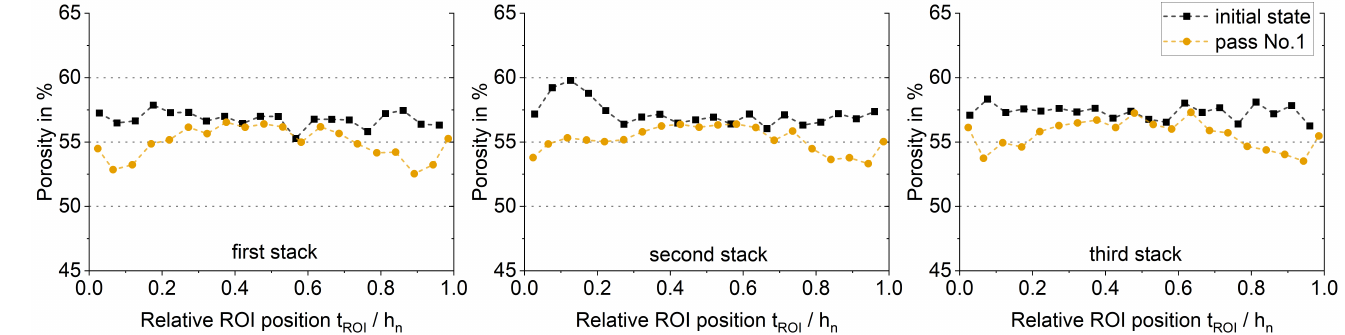
Figure 14. Cross Sections of reconstructed volumes from CT Scans for sample 20-0.50-20 (RD: rolling direction, TD: thickness direction i.e., roll gap direction, WD: width direction i.e., roll width direction, white: material, black: pores): ( a ) RD-WD at t ROI / h n = 0.1 after pass No. 16. ( b ) RD- WD t ROI / h n = 0.5 after pass No. 16. ( c ) RD-TD t ROI / h n = 0 to 1 after pass No. 16. ( d ) RD-TD t ROI / h n = 0 to 0.5 at initial state.